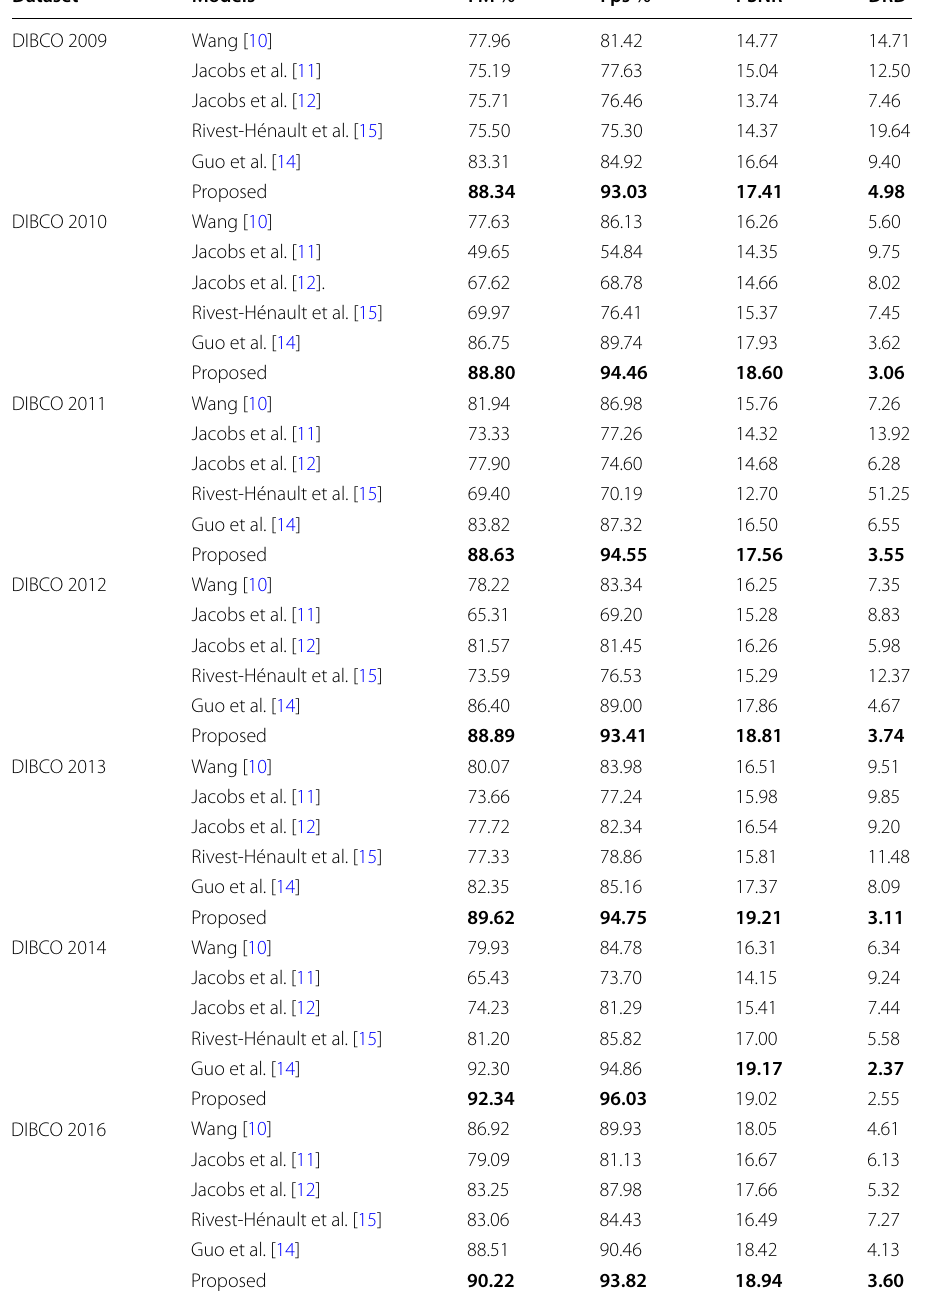
Table 3 Comparison of the performance of the proposed and the other algorithms against DIBCO